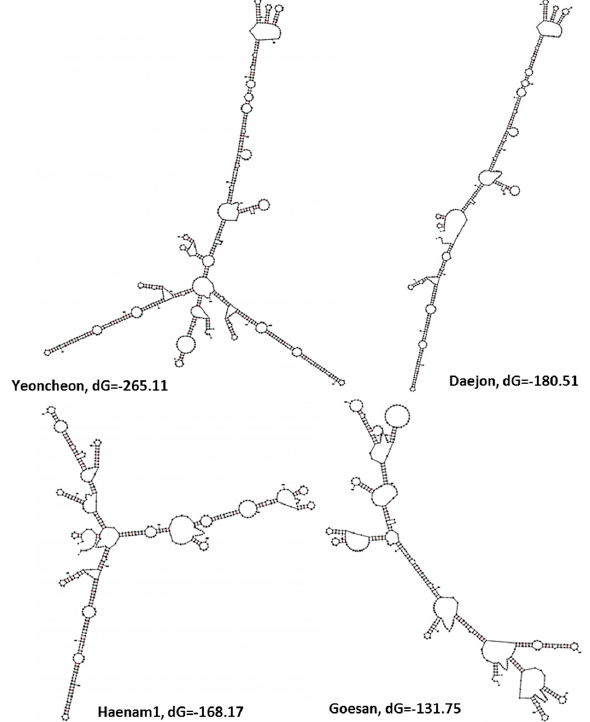
Figure 5. Predicted secondary structures of the most variable region of the LSU of ribosomal DNA of P. brassicae . dG estimates predicted free energy of folded rDNA in kcal·mol − 1 .